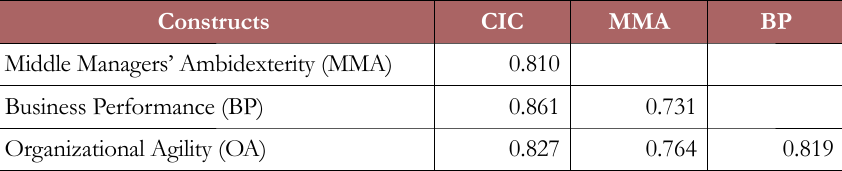
Table 4. Discriminant validity using HTMT (heterotrait-monotrait) score